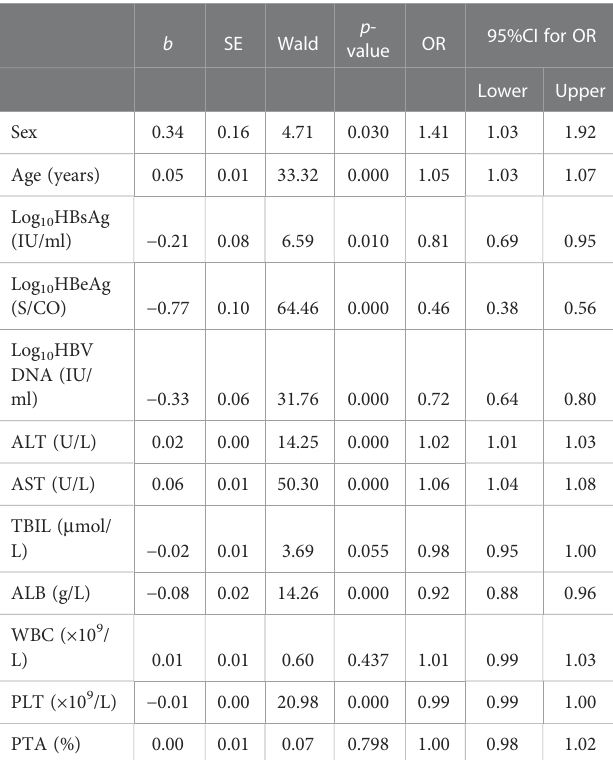
TABLE 2 Univariate logistic regression analysis of the factors of non- minimal liver in fl ammation in patients from the primary